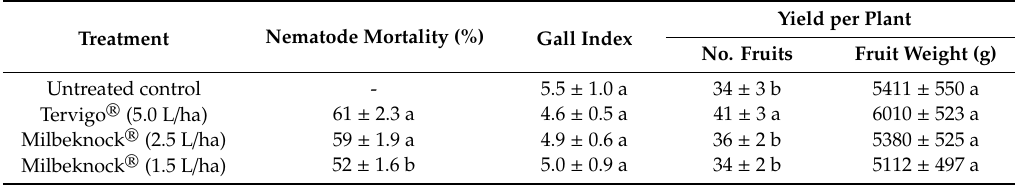
Table 3. E ff ects of abamectin and milbemectin soil treatments on mortality of Meloidogyne incognita soil populations and growth of tomato ‘Amapola’ in field trials.